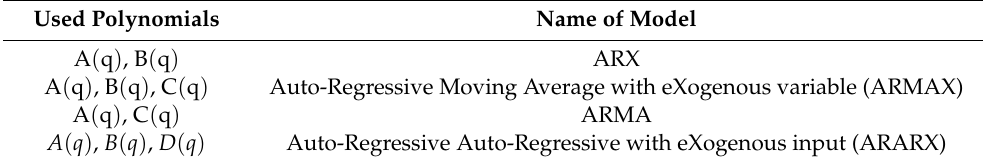
Table 1. Common auto-regressive moving average (ARMA) models shown with their associated polynomials.